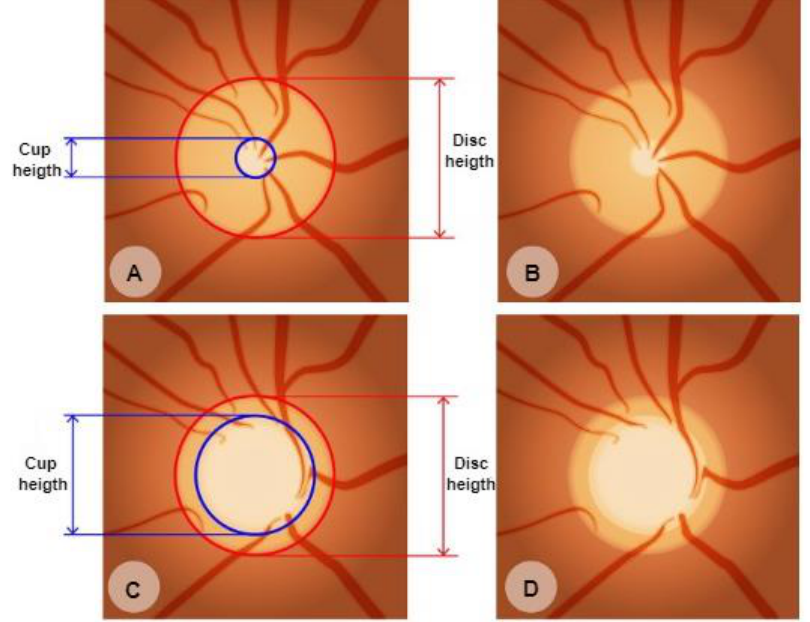
Figure 1. Optic disc with normal cup and increased cup caused by glaucoma: ( A , B ) show optic discs with normal cup and dimension quotes; ( C , D ) show optic discs with increased cup derived from glaucoma. Image from